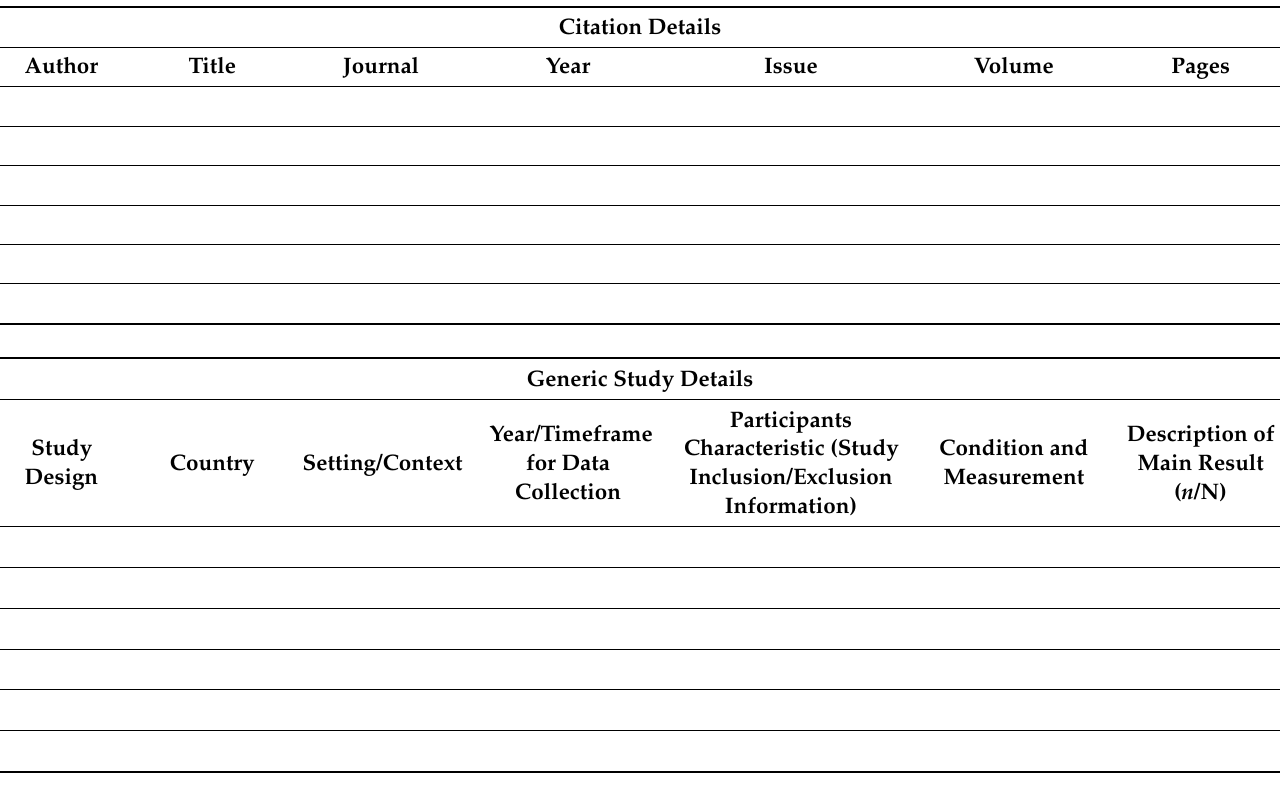
Table A1. Data extraction form for prevalence